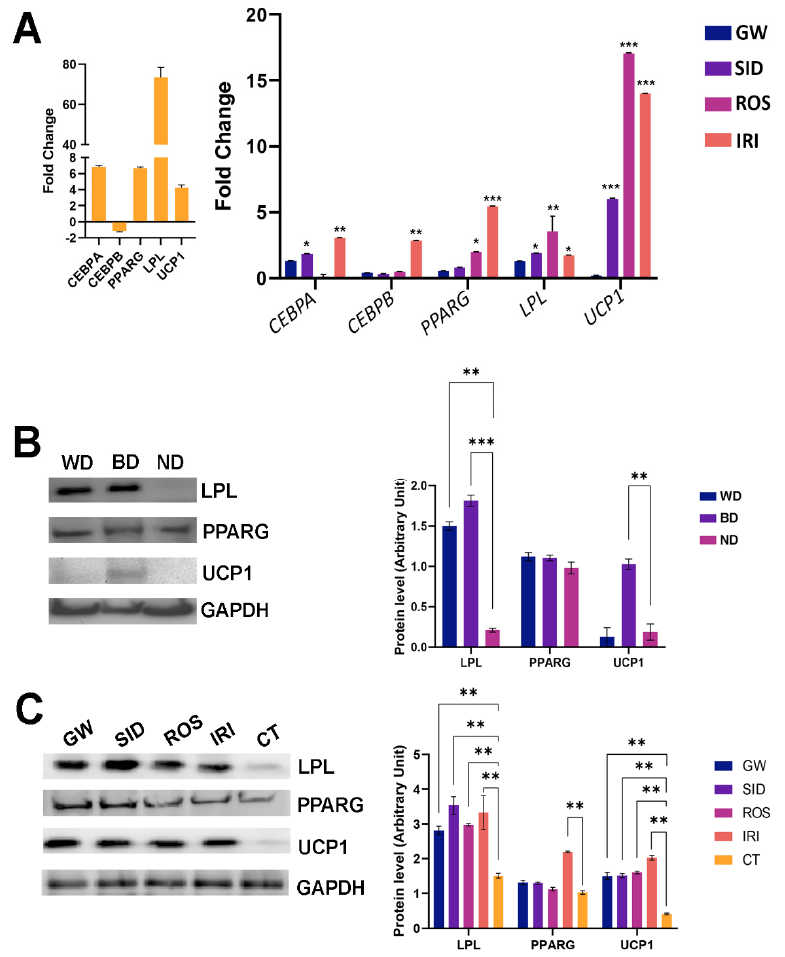
Figure 3. mRNA and protein levels of genes involved in adipocyte differentiation. ( A ): The left histogram shows the expression levels of adipocyte differentiation markers in MSCs following 21 days of incubation in white adipocytes differentiation medium. Data are reported as fold changes in mRNA levels compared to undifferentiated MSCs. The right histogram shows the mRNA levels in white adipocytes treated with browning agents for seven days compared with the control (untreated white adipocytes). Data are reported as fold changes in mRNA levels compared with control (white adipocytes) indicated as 1. Fold change values for genes were calculated as the ratio of the signal values of the experimental (drug-treated samples) group compared with the control group. ( ± SD, n = 3 biological replicates; * p < 0.05, ** p < 0.01, *** p < 0.001). ( B ): in vitro differentiation models. The protein levels of differentiation markers in MSC cultures following induction of white (WD) and brown (BD) adipocyte maturation, respectively. ND stands for control undifferentiated cultures. The right graph shows the expression levels of analyzed markers. Data are reported as arbitrary units compared with control (ND) ( ± SD, n = 3 biological replicates; ** p < 0.01, *** p < 0.001). ( C ): protein levels of differentiation and browning/thermogenic markers in white adipocytes (differentiated MSCs) that were treated with the above-reported drugs. CT stands for differentiation without drug supplementation. The graph shows the expression levels of analyzed markers. Data are reported as arbitrary units compared with control (CT) ( ± SD, n = 3 biological replicates; ** p < 0.01). GW: GW501516; SID: sildenafil; ROS: rosiglitazone; IRI: irisin. Drug concentration: 1 nM (GW); 1 nM (SID); 43 nM (ROS); 20 nM